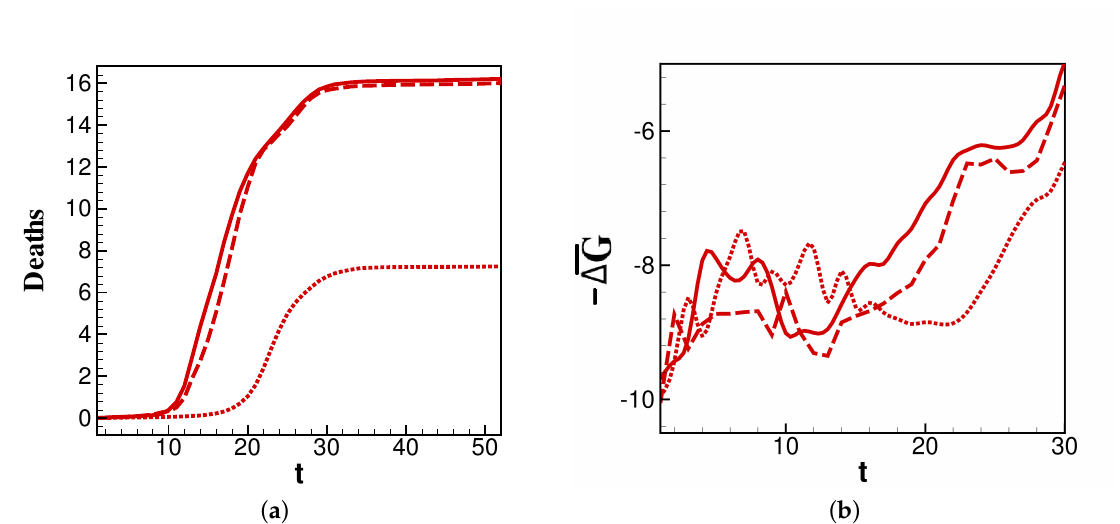
Figure 3. ( a ) The number of deaths weekly in NYC for the influenza seasons beginning 2014 (solid), 2015 (dotted), and 2016 (dashed) and ( b ) the values of ¯ ∆ G D for the corresponding influenza seasons. This graph is cut to t = 30 to capture just the area of concern.